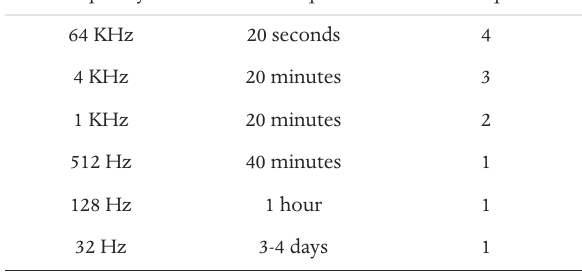
Table 1. Details of sampling frequencies acquired with duration of acquisition.